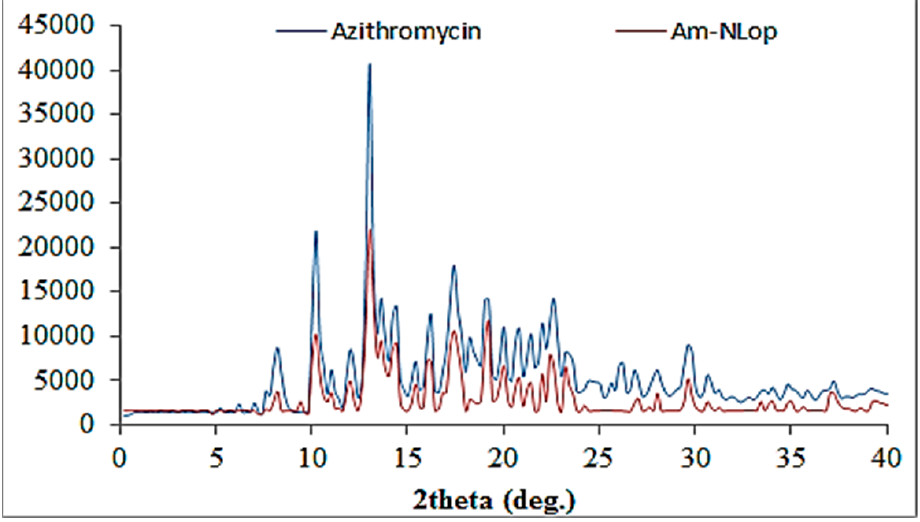
Figure 5. XRD image of Azithromycin and Azithromycin-loaded nano lipid carrier (AM-NLop).